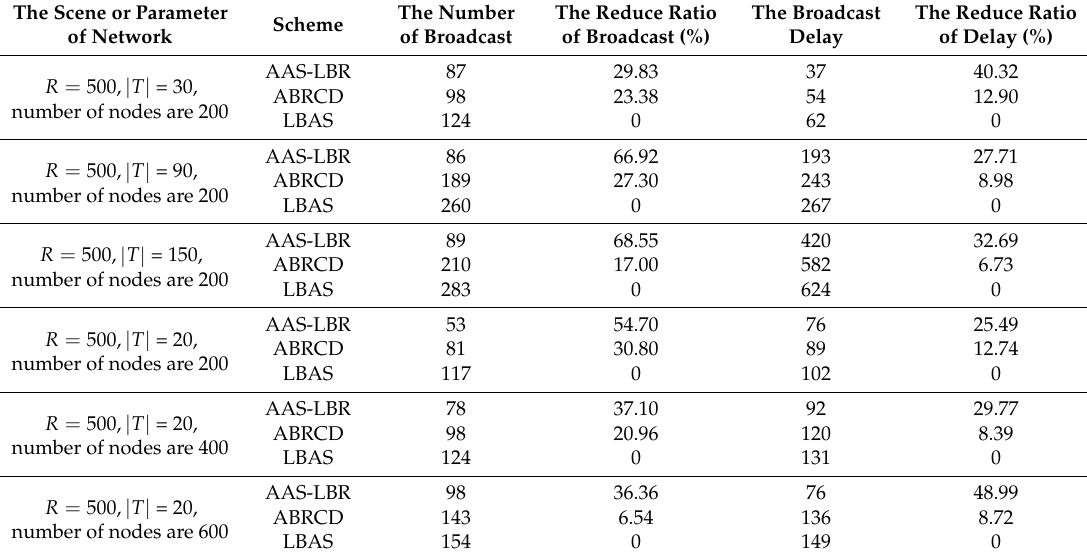
Table 6. Performance comparison.